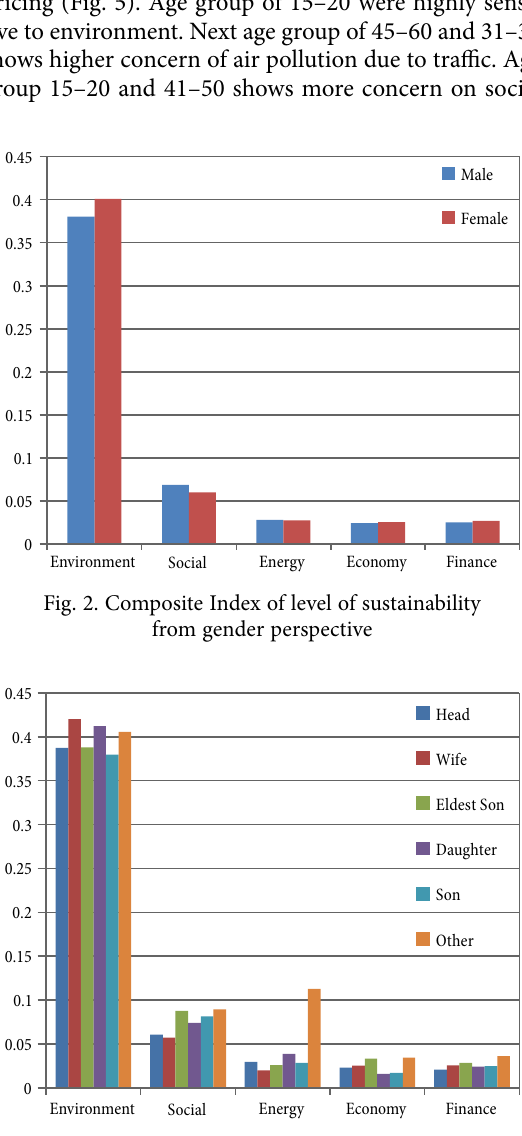
Fig. 5. Composite Index of level of sustainability from income